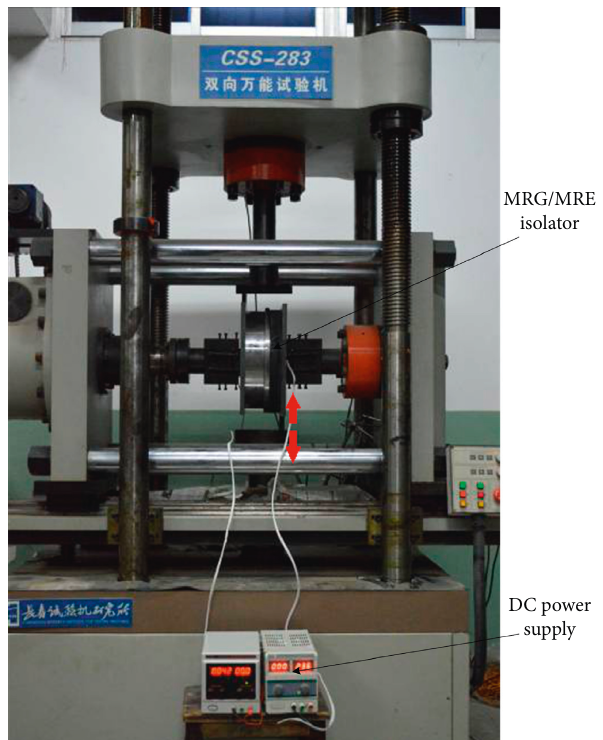
Figure 12: The experimental installation of the MRG/MRE isolator.